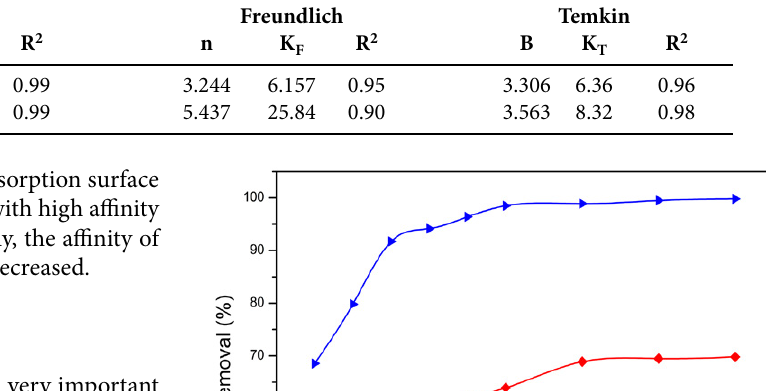
Table 1 . Fitting parameters and goodness of fit for three different isotherm models (Langmuir, Freundlich and Temkin) applied to experimental adsorption data. Adsorbents